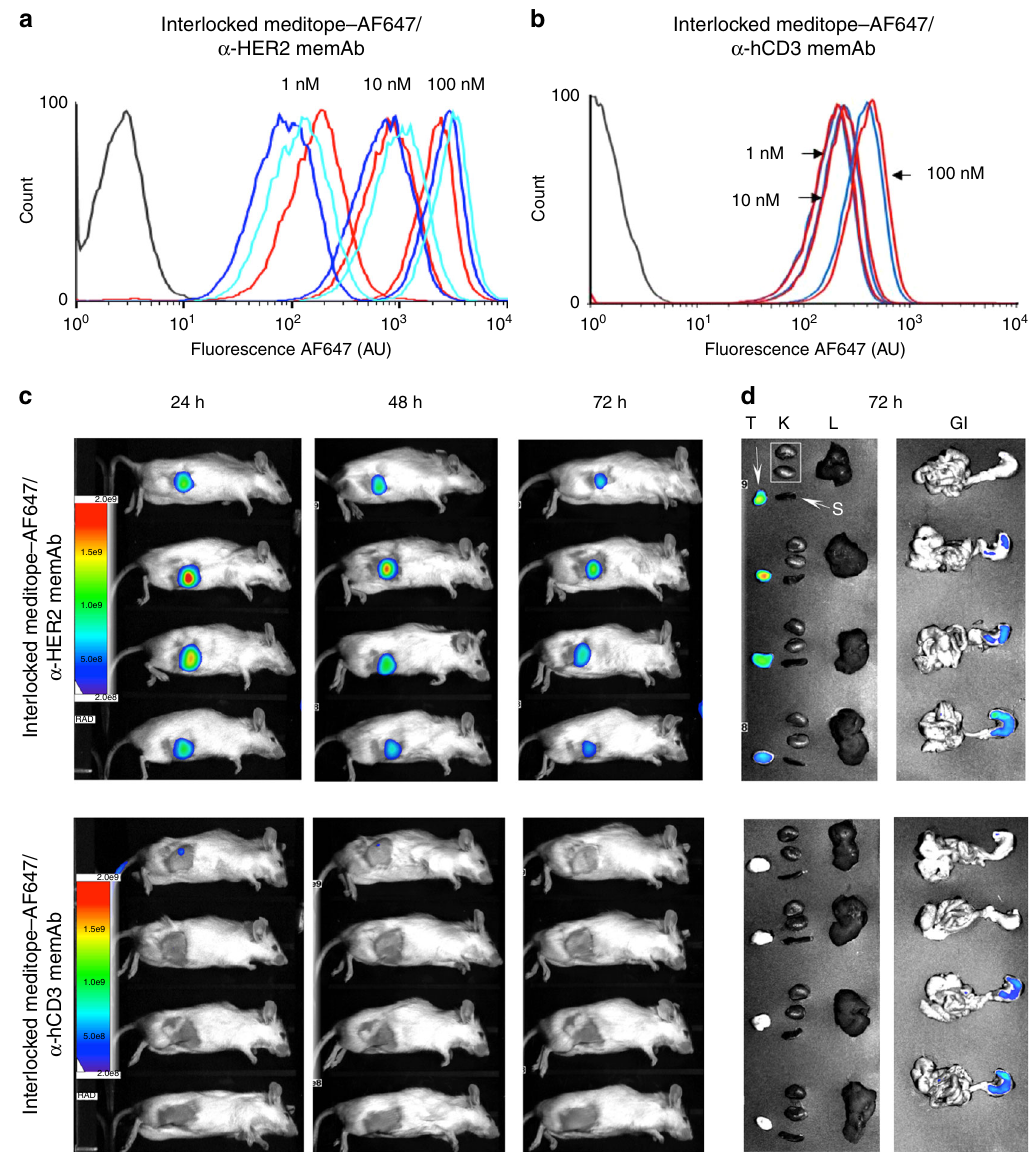
Fig. 3 In vivo imaging. a Analytical fl ow cytometry analysis of BT474 HER2 overexpressing breast cancer cells incubated with 1, 10, or 100 nM of Ile83Glu anti-HER2 memAb with 5-diphenylalanine meditope – AF647 at a 1:1 molar ratio (blue), Ilu83Glu anti-HER2 memAb directly labeled with AF647 (green) or with mechanically interlocked 5-diphenylalanine-8-Arg-(PEG) 2 -azido-meditope – DIBO – AF647 Ile83Glu anti-HER2 memAb (red). b Analytical fl ow cytometry analysis of PBMCs incubated with 1, 10, and 100 nM labeled antibodies. The red trace is the mechanically interlocked,